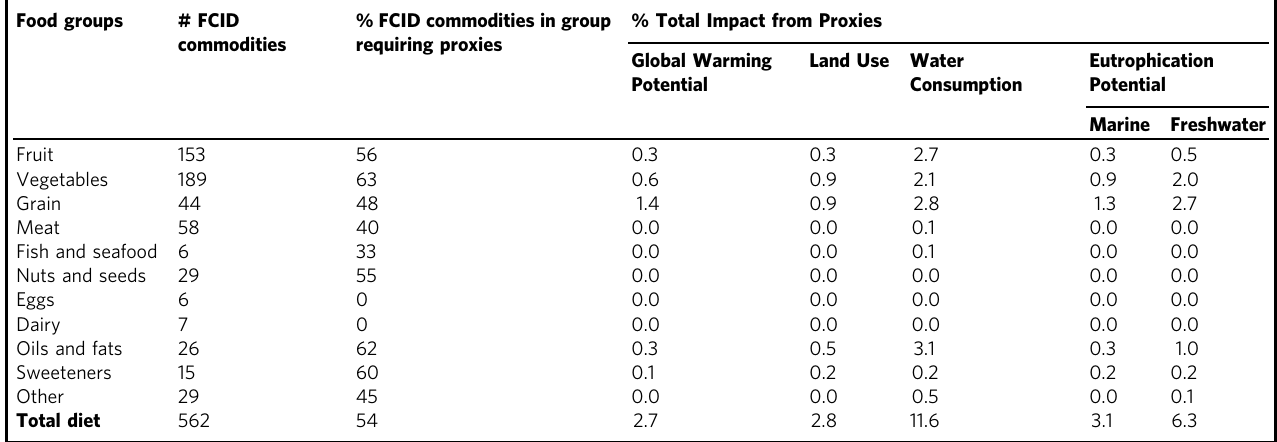
Table 3 Use of proxies in linkages to FCID and percent contribution of proxies to total impacts, by food group. Food groups # FCID